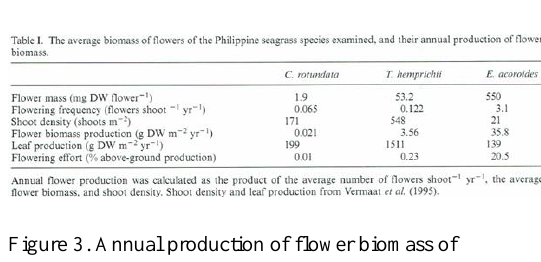
Figure 3. Annual production of flower biomass